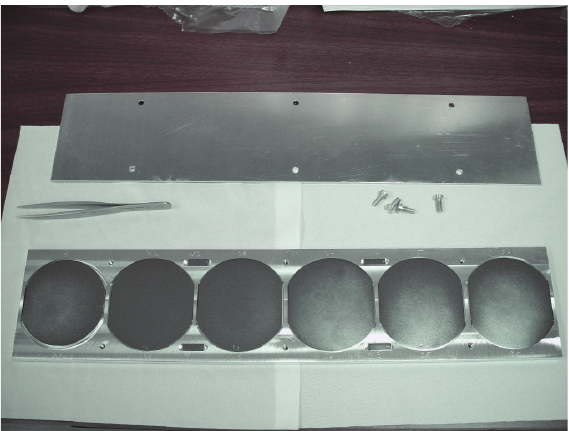
Figure 8: Six out of nine wafers in the Al holder before the neutron irradiation that took place at MIT between 2012 and